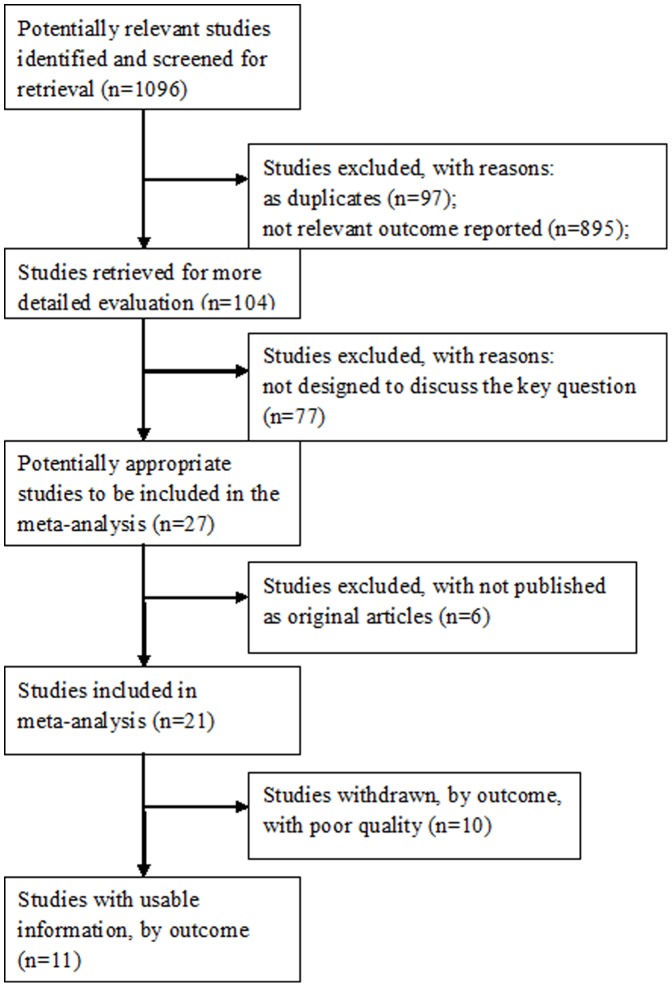
Flow of included studies.The reasons for exclusion included: no relevant outcome reported (n = 895); duplicates (n = 97); not designed to discuss the key question (n = 77); not considered an original publication or research (i.e., letters, abstracts, reviews, editorials, etc.) (n = 6); poor quality (n = 10, including studies containing data on patients that were not in accordance with our diagnostic criteria (n = 9); or the study was not designed as a cohort study (n = 1)). Therefore, two prospective cohort studies and nine retrospective cohort studies were included in our meta-analysis.